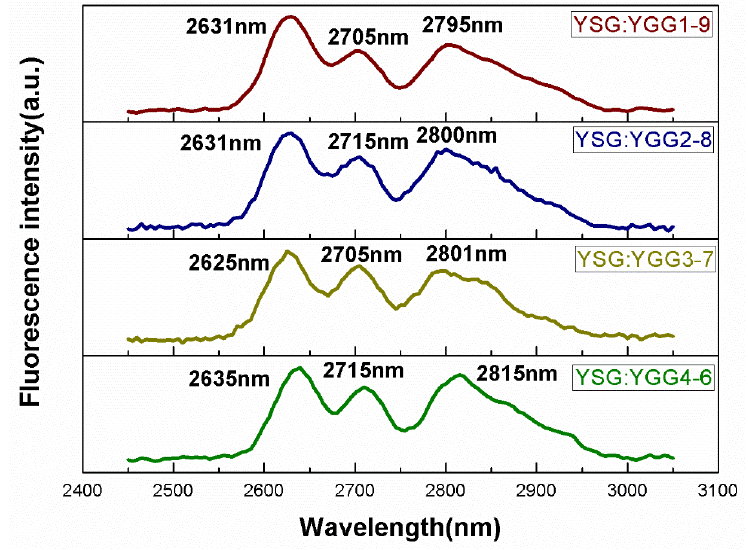
Figure 5. The MIR fluorescence spectra of the samples of YSG:YGG from 1:9 to 4:6 at 2450–3050 nm.